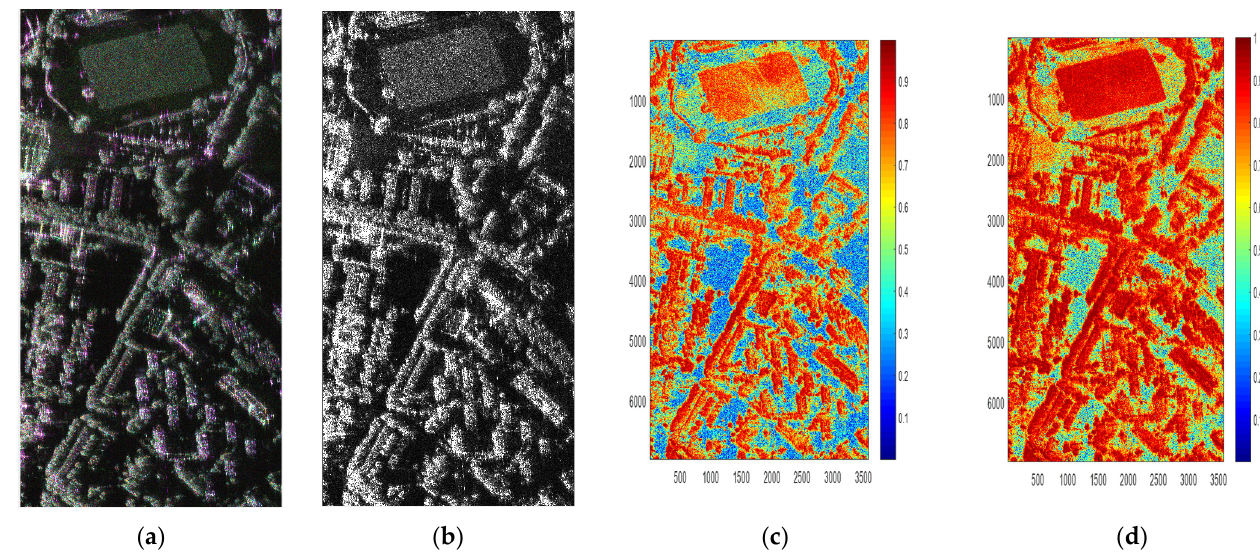
Figure 6. Decomposition results and Coherence. ( a ) Pseudo color image. ( b ) Image of polarimet- ric Interferometric optimal decomposition. ( c ) Coherence of single scattering. ( d ) Coherence of polarimetric interferometric optimal